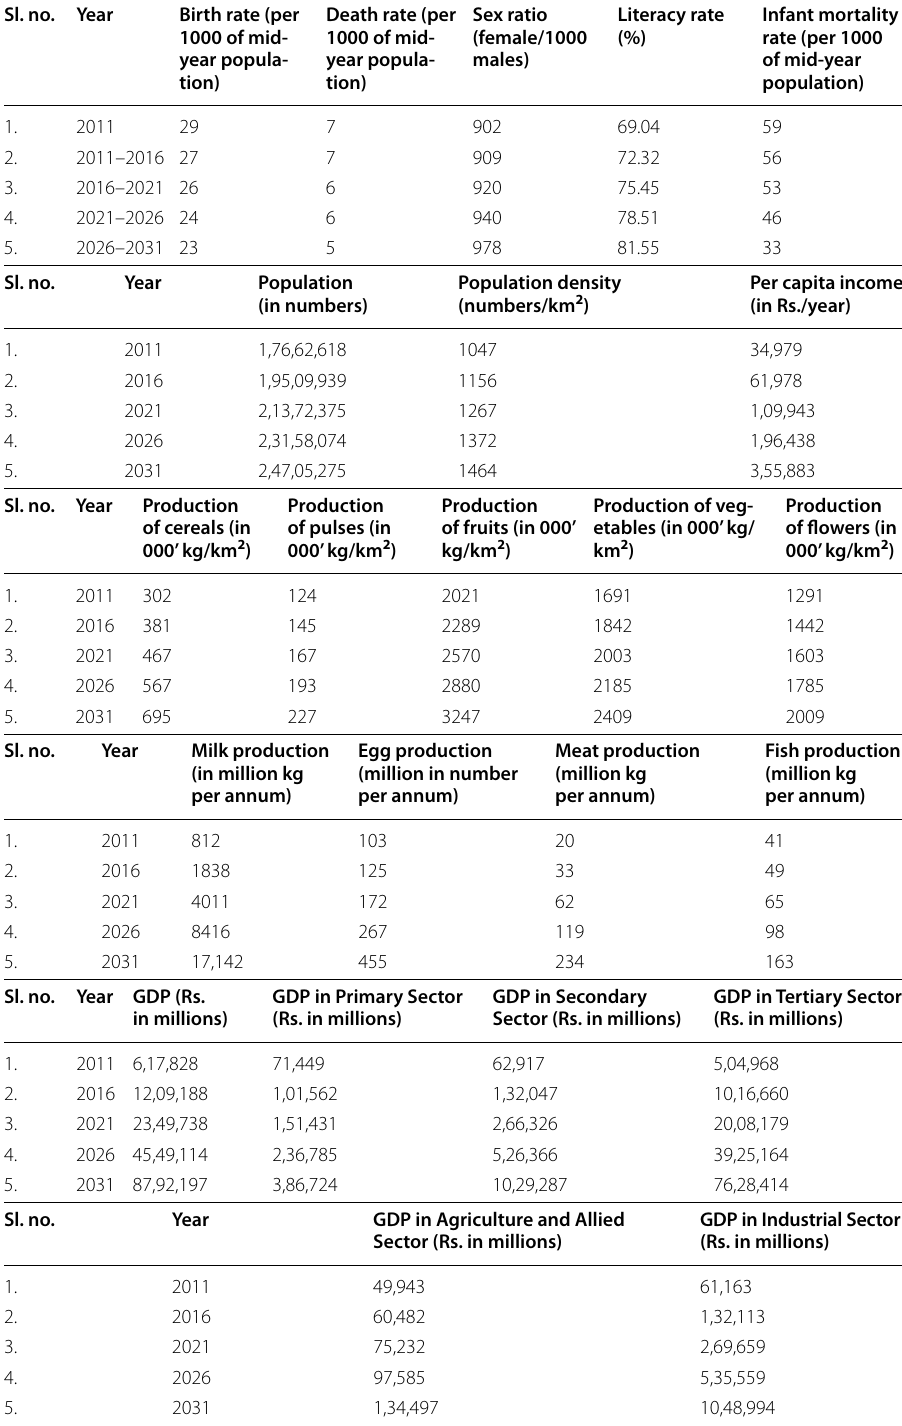
Table 14 Perceived phasewise